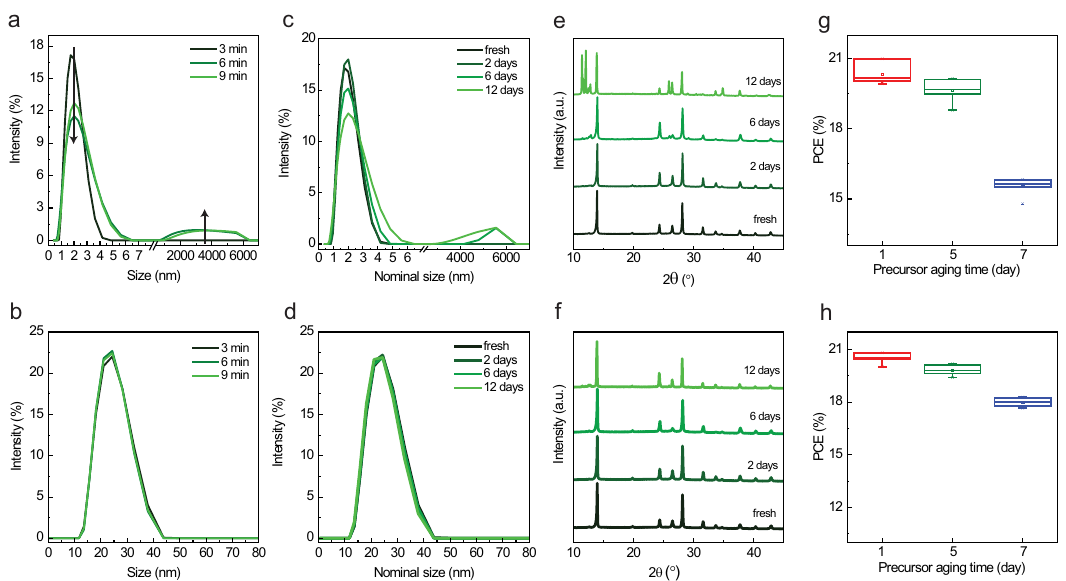
Fig. 6 Perovskite precursor stability. a , b DLS data of fresh precursor solutions a without and b with co-solvent dilution. The data were collected at different scans (each scan takes 3 min). c – f DLS data and XRD pattern of aged precursor solutions ( c , e ) without and ( d , f ) with co-solvent dilution. g , h Distribution of PCE of PSCs fabricated as a function of the aging time of a precursor solution g without and h with so-solvent dilution. The perovskite fi lms were used for device fabrication without any surface passivation